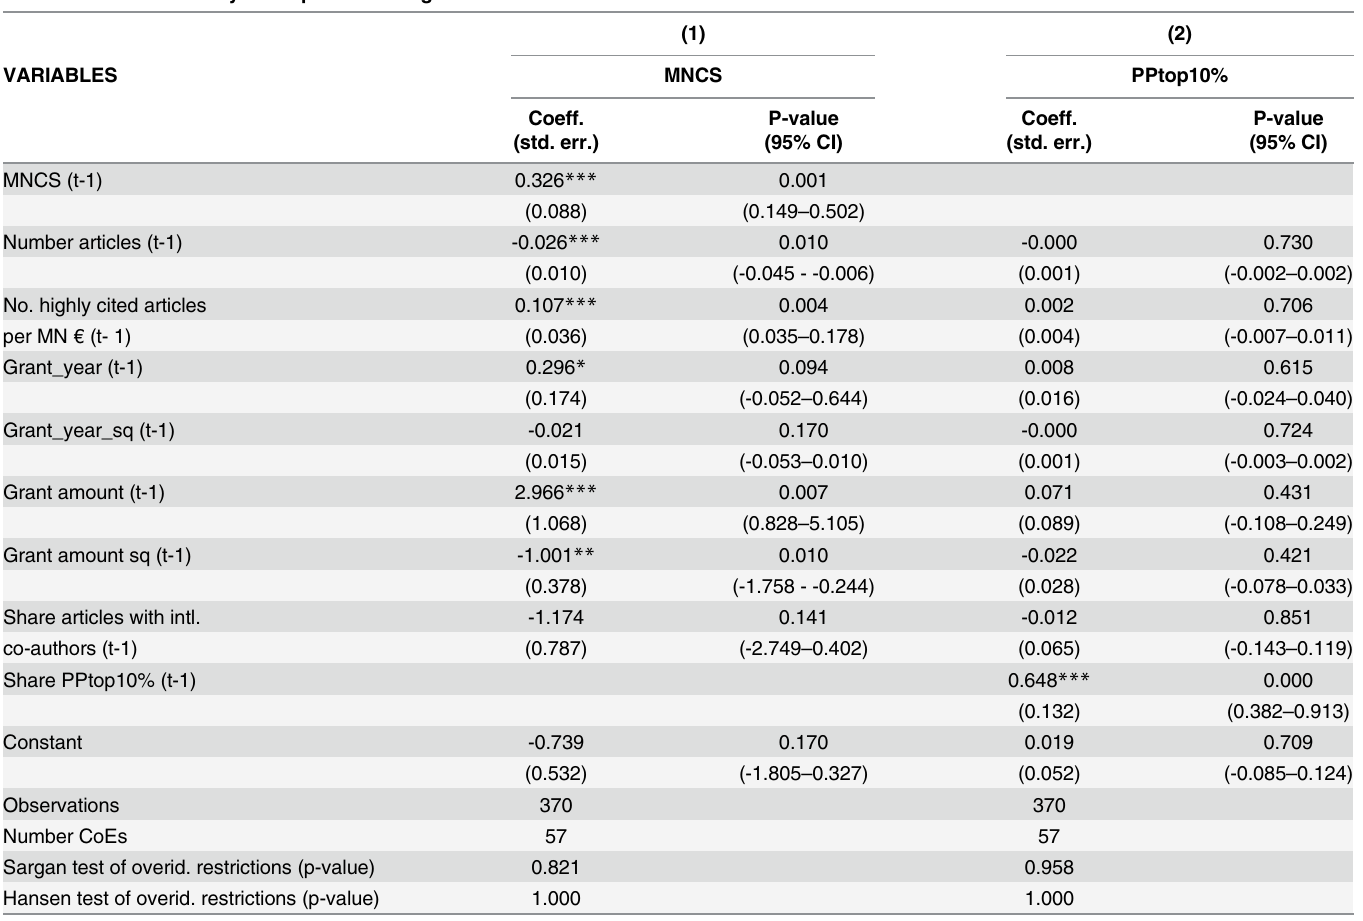
Table 4. Results of the dynamic panel data